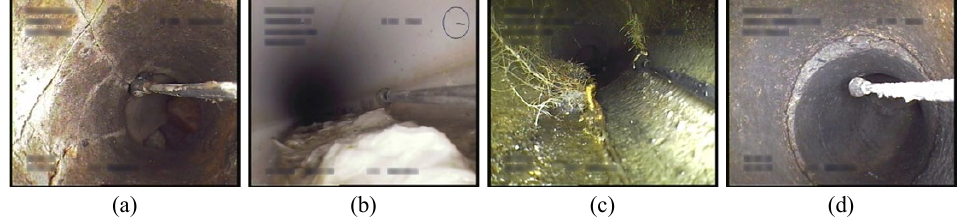
Table 1. Distribution of defect labels.